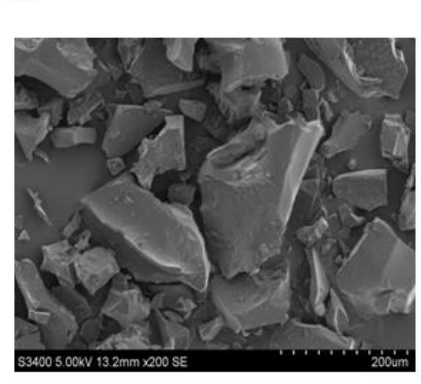
Figure 3. SEM images of freeze-dried microparticles. WPI + LA + CT ( A ), MD + LA + CT ( B ), WPI + MD + LA + CT ( C ). WPI + LA + CT: Whey protein isolate + L. acidophilus + Charantin ; MD + LA + CT: Maltodextrin + L. acidophilus + Charantin; WPI + MD + LA + CT: Whey protein isolate + L. acidophilus + Maltodextrin + L. acidophilus + Charantin .